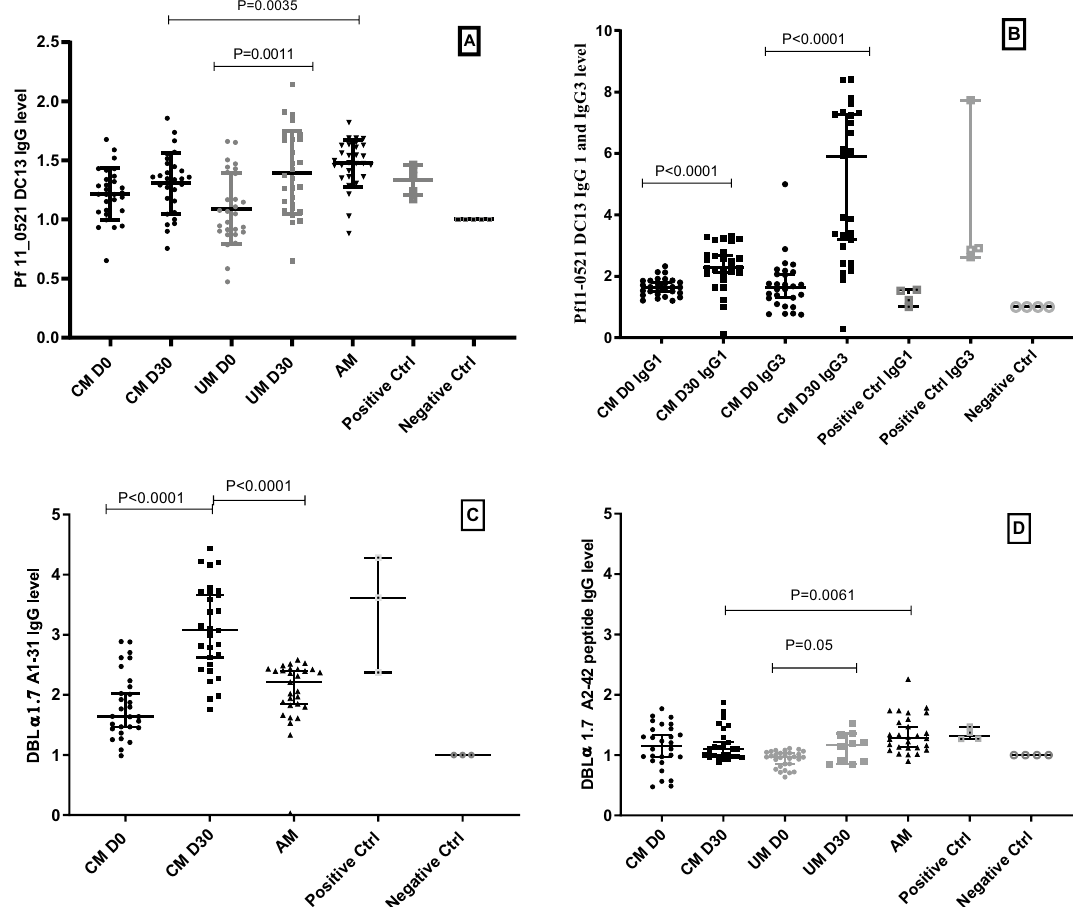
Figure 1. ( A ) IgG response against Pf11_0521DC13 in children with cerebral malaria (CM) at Day 0 black circles, at Day 30 black squares, in children with uncomplicated malaria (UM) at day 0 Grey circles and at day 30 Grey squares. ( B ) IgG1 and IgG3 response of CM children at Day 0 black circles and at Day 30 black squares. ( C ) IgG response against the DBLα A1-31 peptide in CM children and ( D ) IgG response of CM and UM children to the DBLα A2-42 peptide. In all graphs black triangles, empty square, empty circle highlights respectively Asymptomatic children (AM) the positive control and the negative